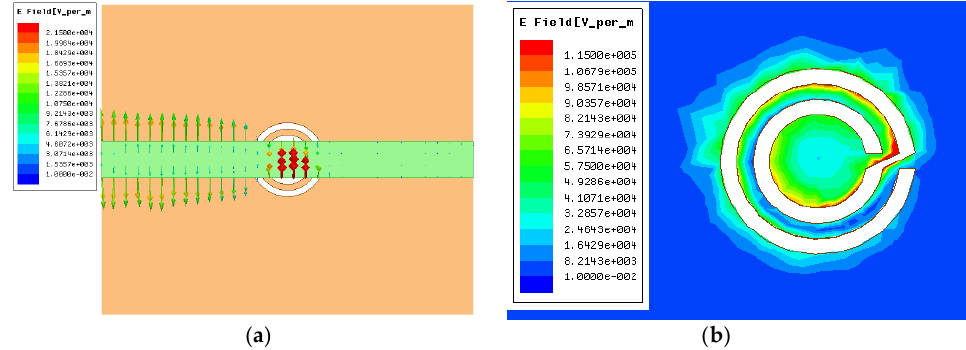
Figure 2. ( a ) Excitation of the CCSR with the help of an electric field generated by the microstrip transmission line; ( b ) Distribution of the electric field in the CCSR at resonance.